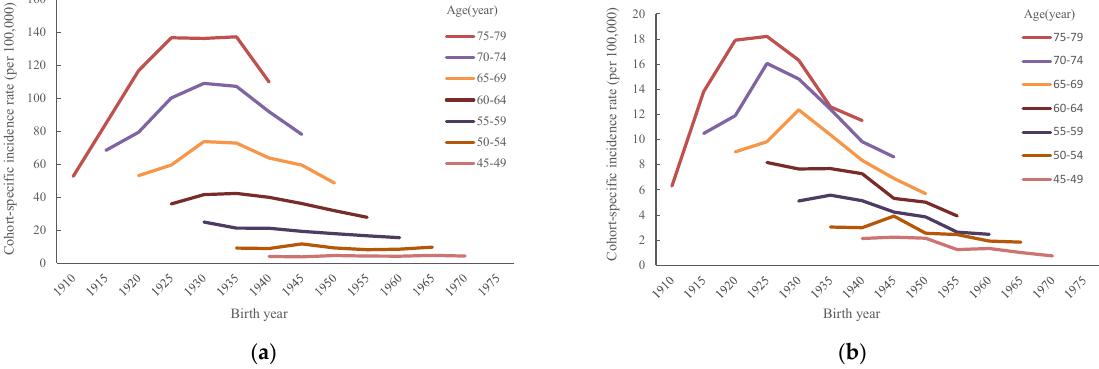
Figure 1. Age-adjusted incidence rates of lung cancer and squamous cell lung carcinoma stratified by sex in Taiwan between 1985 and 2019. Table 1. Net drift and local drift by age groups of squamous cell lung carcinoma in Taiwan between 1985 and 2019. Figure 2 depicts the age-specific incidence of SQC from 1985 to 2019, which indicates that, in different periods, the incidence increased with age and decreased more rapidly in men than in women. Taking 2000 to 2004 as an example, the incidence in men per 100,000 population was 0.28 at the age of 30 to 34 years and reached 136 at the age of 75 to 79 years; the incidences for women in these age groups were 0.2 and 18, respectively, per 100,000 population. Table 1 presents the AAPC and APC for SQC in each age group for both sexes. The AAPC values revealed that the age-adjusted incidence declined more dra- matically in women ( − 2.3791%) than in men ( − 0.272%). A comparison of the APCs of dif- ferent age groups indicated that the incidence of men changed little for groups younger than the age of 75 to 79 years; the decrease for young women was more significant. The APC is 2.3699% (95% CI: 2.0465, 2.6944) for males and 1.2056% (95%CI: 0.3414, 2.0771) for females annually at the age group of 75 to 79 years. Figure 2. Age-specific incidence rates of squamous cell lung carcinoma in Taiwan between 1985 and 2019 by calendar periods and age groups: ( a ) men and ( b ) women.